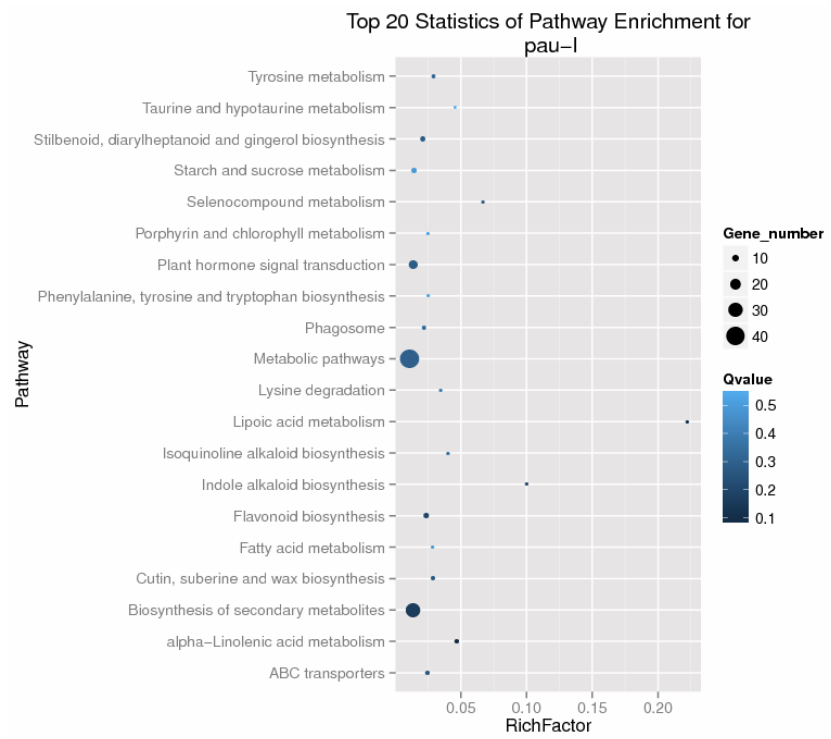
Figure 4. Scatter chart of top 20 pathway enrichment for the co-expressed DEGs.